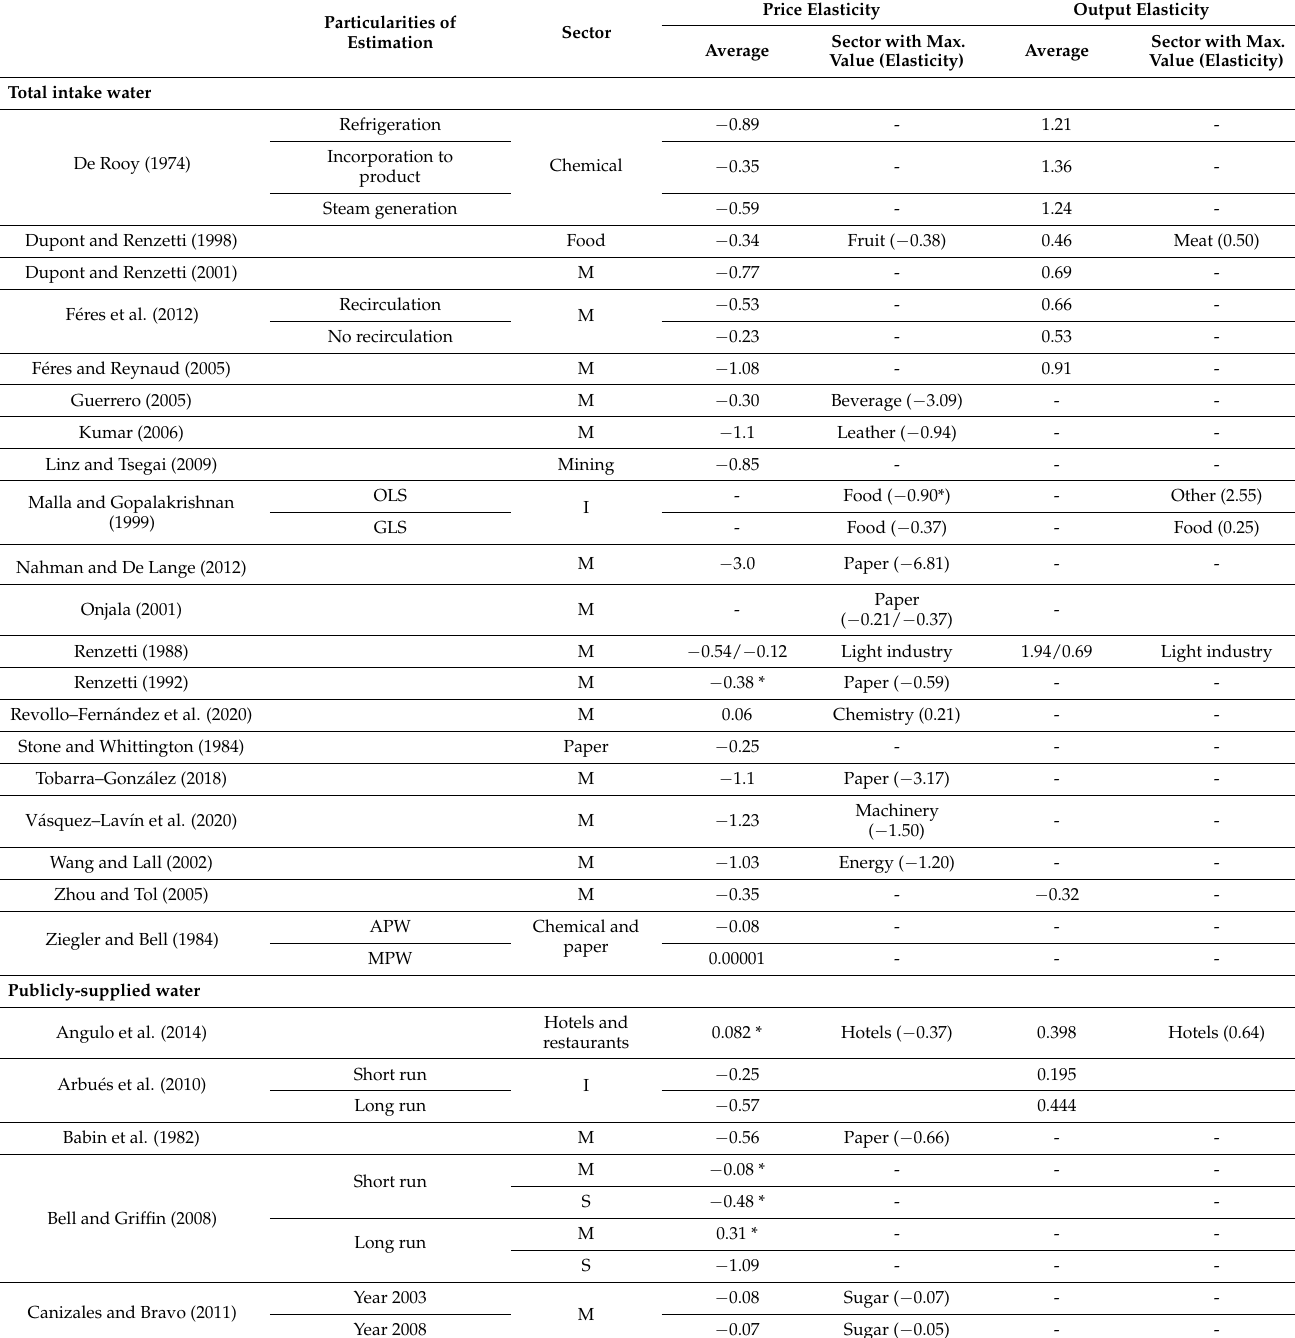
Table 4. Direct price and output elasticities of